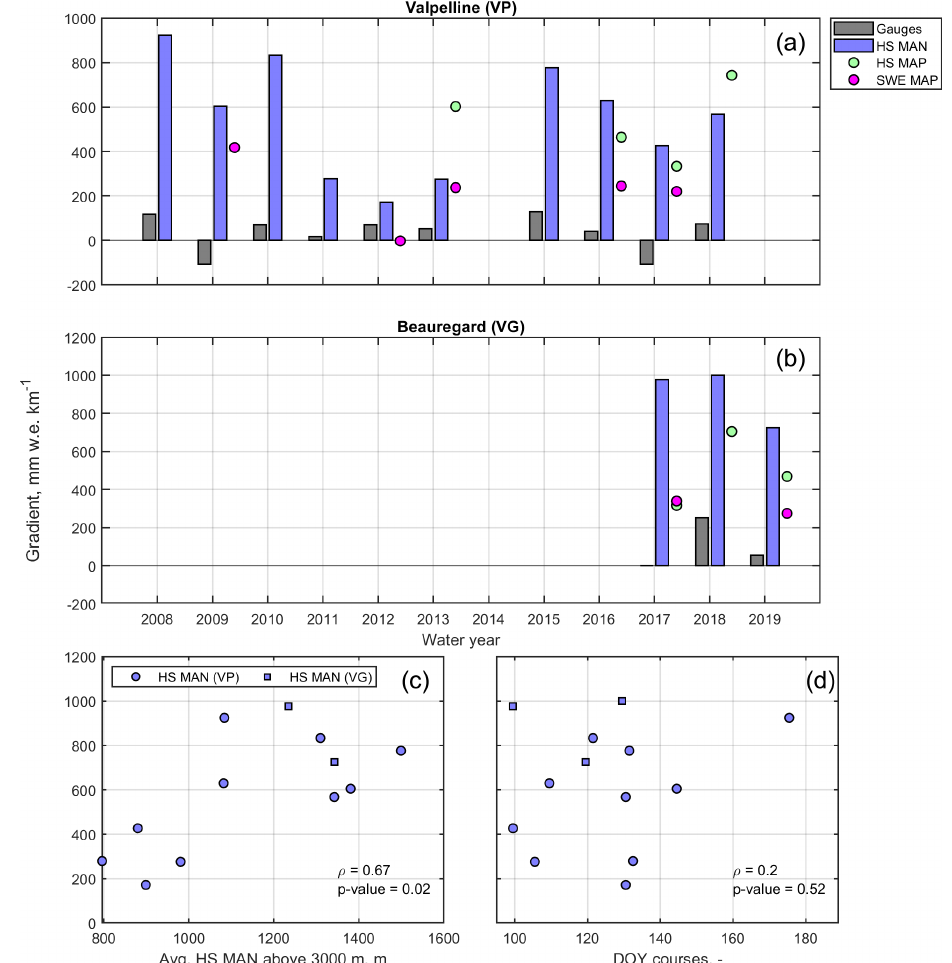
Figure 5. Annual winter orographic gradients estimated by precipitation gauges, snow courses (HS MAN), and the two snow maps assimi- lated by Flood-PROOFS at Valpelline (a) and Beauregard (b) . The HS map and SWE map are the snow depth sensor map and the SWE map, respectively. Details on Flood-PROOFS and these assimilated maps are reported in Sect. 3.3. Panels (c) and (d) show estimated orographic gradients by snow courses as a function of mean course snow depth above 3000ma.s.l. (average HS MAN) and survey day of the year (DOY), respectively. ρ is the Pearson correlation